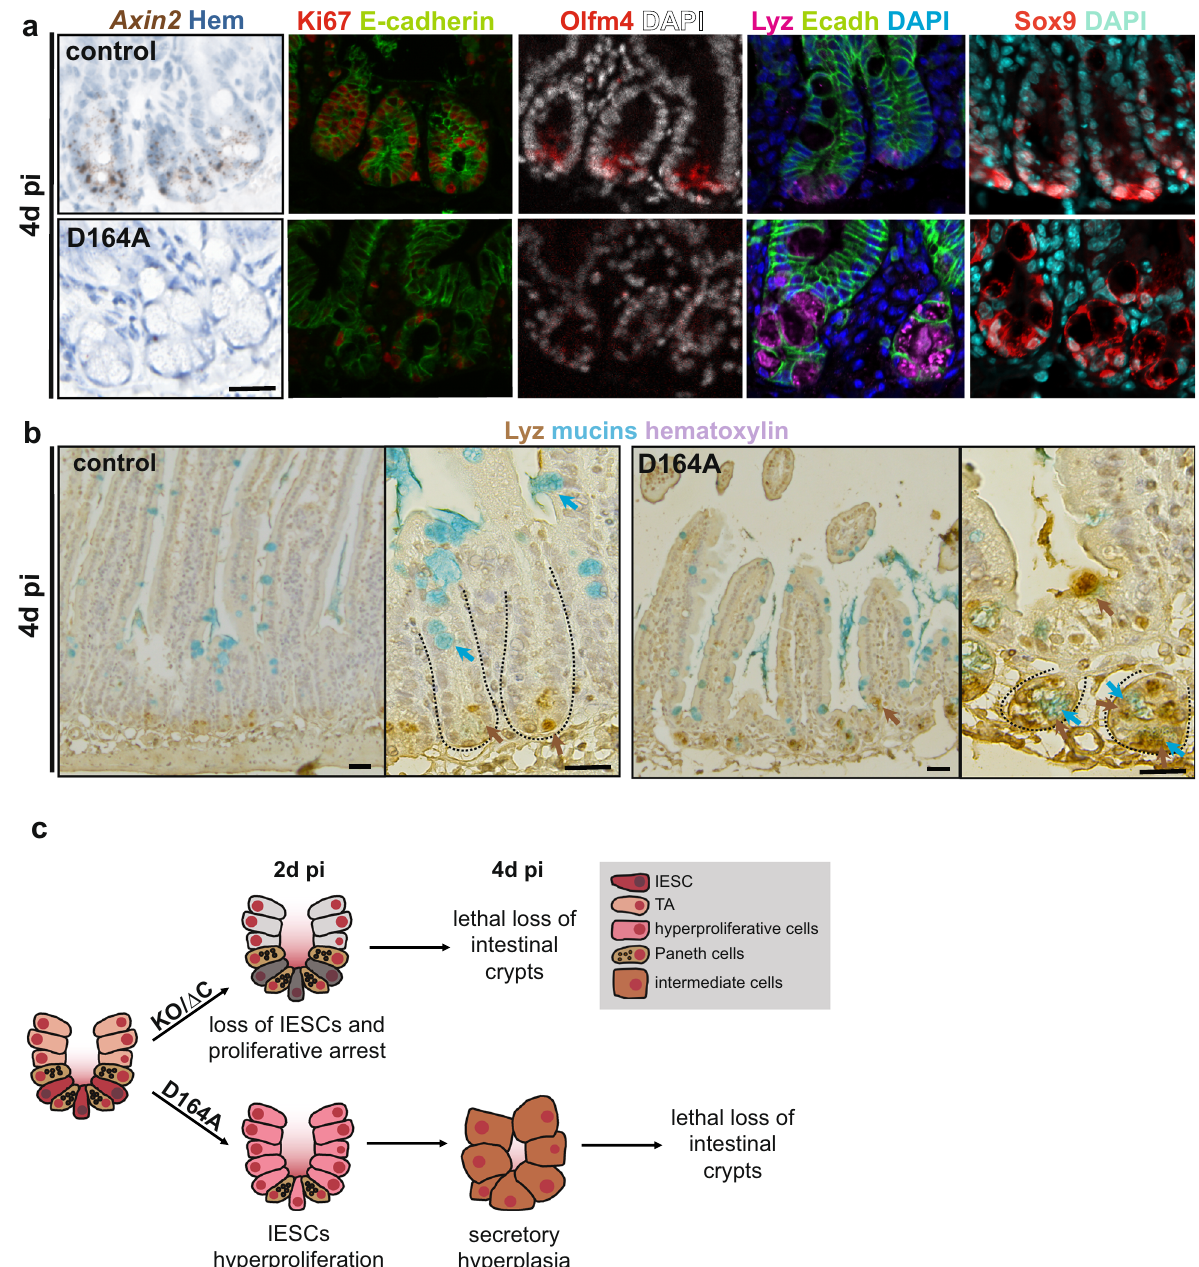
Fig. 2 Intestinal crypts lacking the output via N-terminal recruited co-factors to exhibit stem cell loss and secretory hyperplasia 4d pi. a Axin2 (Wnt- target) in situ hybridization, Olfm4 (IESC marker), Ki67 (proliferating cells), lysozyme (Lyz, Paneth cells) and Sox9 (Paneth cells precursors) immuno fl uorescence of control ( villin-CreER T2 ;Ctnnb1 wt/ fl ox ) and D164A ( villin-CreER T2 ;Ctnnb1 D164A/ fl ox ) duodenal crypts. Hematoxylin (nuclei), DAPI (nuclei) or E-cadherin (cell shape) for counterstain. Timepoint: 4d pi. Scale bar, 20 μ M. Representative images of three biological replicates. b Paneth cells and goblet cells visualized by Lyz-HRP and alcian blue (mucins), respectively. Hematoxylin as counterstain. Brown arrows indicate Lyz + cells, which are also found mislocalized to the villus of D164A animals. Blue arrows indicate mucin-expressing cells. Insets show higher magni fi cation of crypts. Timepoint: 4d pi. Scale bar, 20 μ M. Representative images of three biological replicates. c Working model summarizing impacts of the missing contribution of N- vs. C-terminal β -catenin